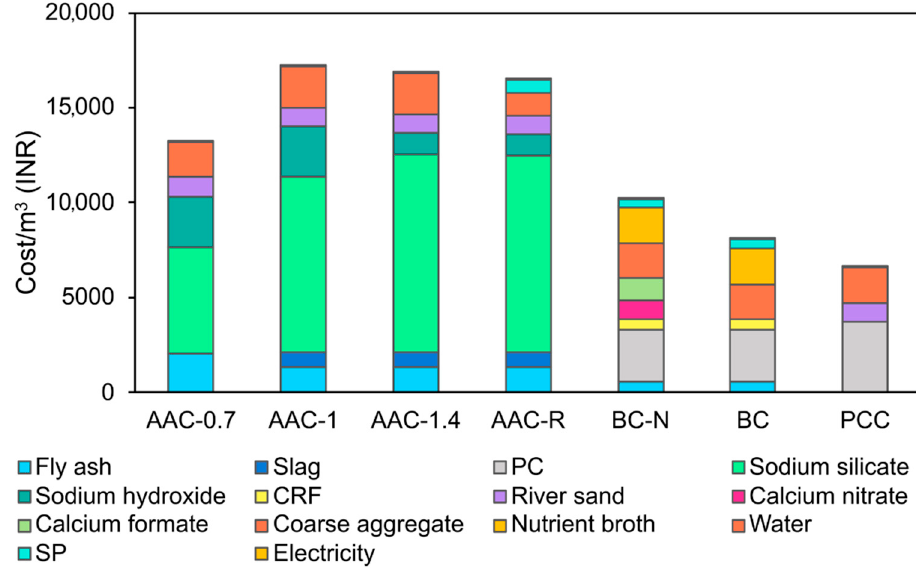
Figure 8. Cost estimate of different concrete mixes.